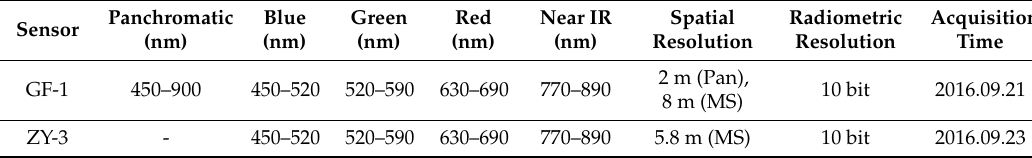
Table 2. Characteristics of GF-1 image.